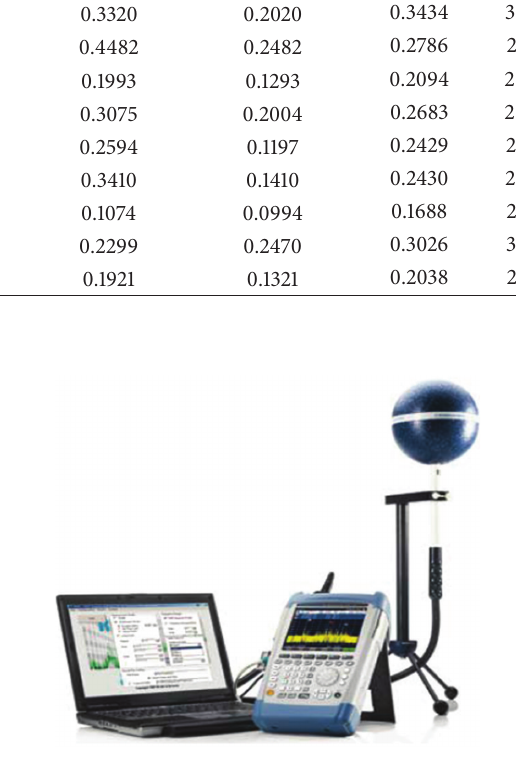
Figure 5: Portable system for EMF